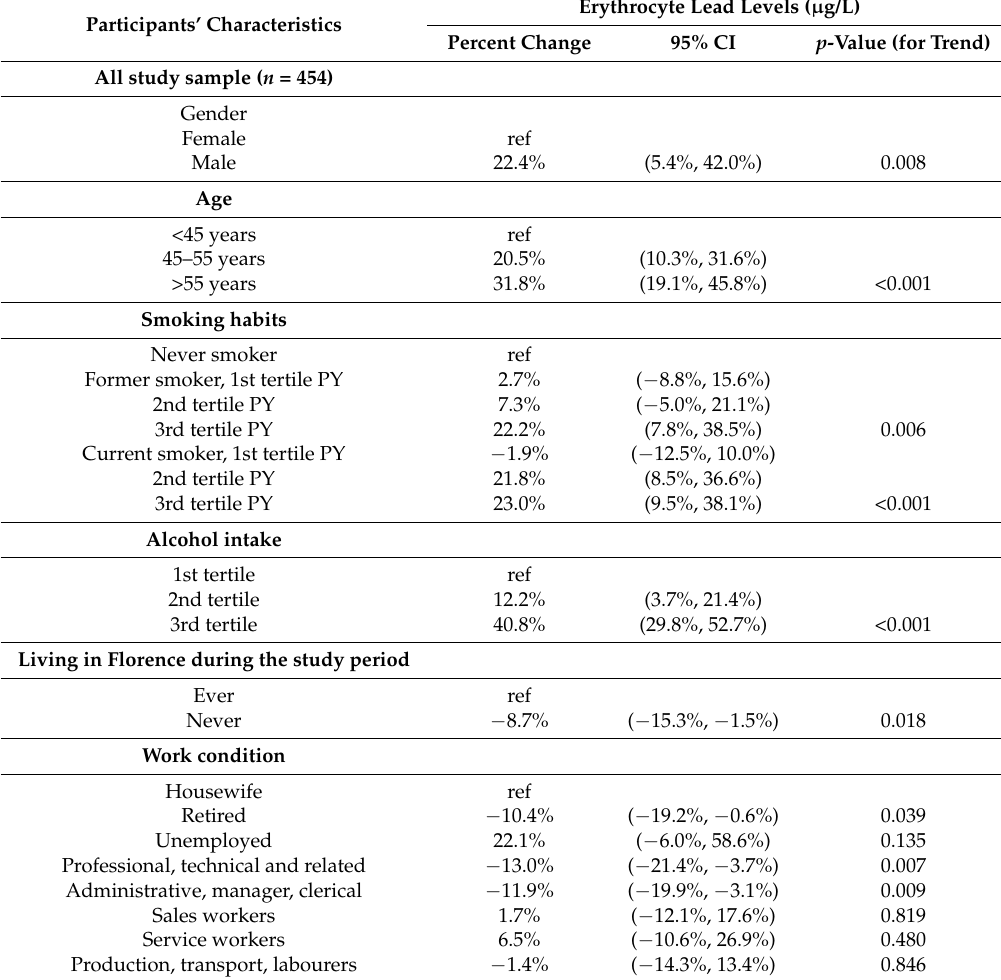
Table 3. Association between selected participants’ characteristics and erythrocyte lead